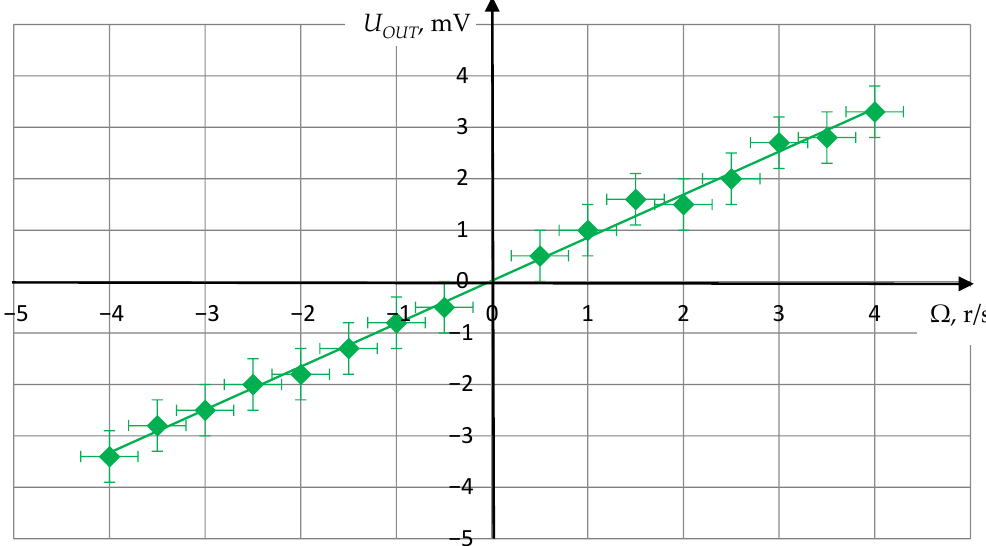
Figure 13. The experimental dependence of the output voltage on the rotation rate of RRS SE on CPAW.